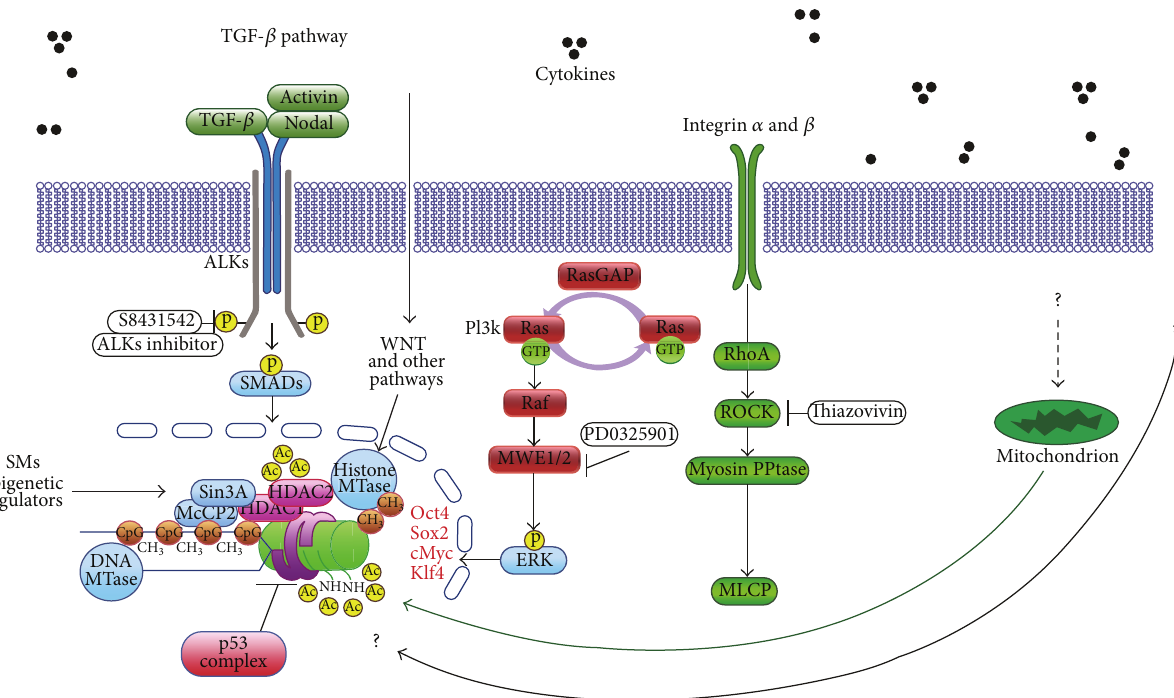
Figure 3: Human CiPSC perspective regulation pathways. The human CiPSC generation is so complicated that needs a lot of cellular reorganization, signaling pathways changes, and extracellular matrix maintaining conditions to achieve final reprogrammed pluripotent stem cell status. The cells were induced by chemicals through epigenetic modifications that switch on pluripotency transcription factors, such as Oct4, Nang, Sox2, Klf4, and c-Myc. The cell signaling pathways including TGF beta, WNT, ERK, ROCK, mitochondria, and other signaling pathways might need to be regulated in human CiPSC generation. However, waiting to be discovered mechanisms might also be some other unknown cell signaling pathways as well as nuclear and mitochondria genomic